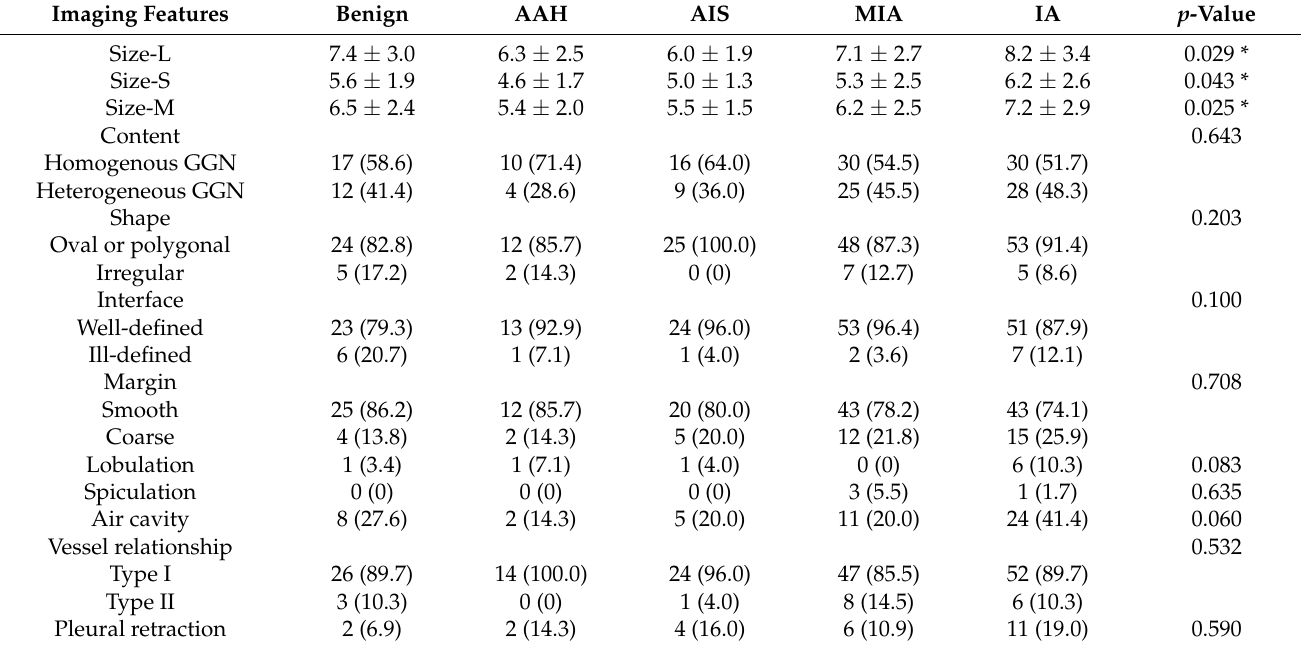
Table 2. Analysis and comparison of computed tomographic findings.